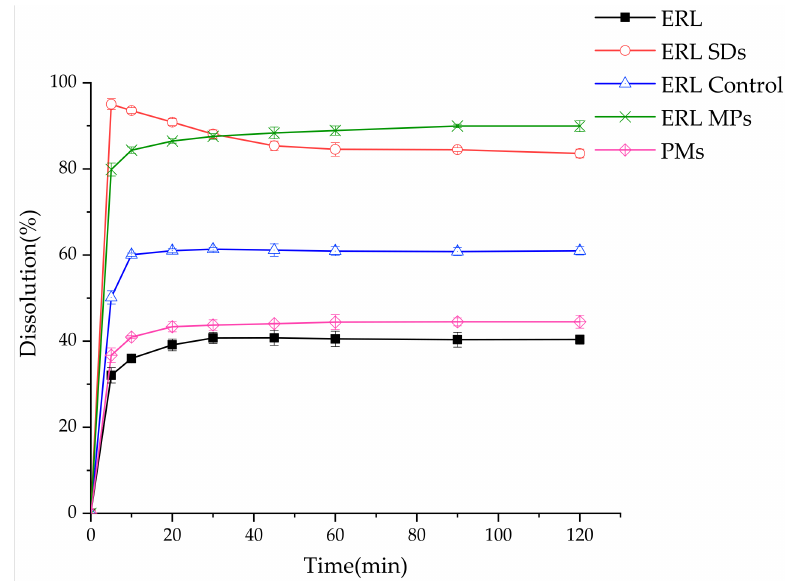
Figure 8. Dissolution curves of ERL, ERL SDs, ERL control, ERL MPs and